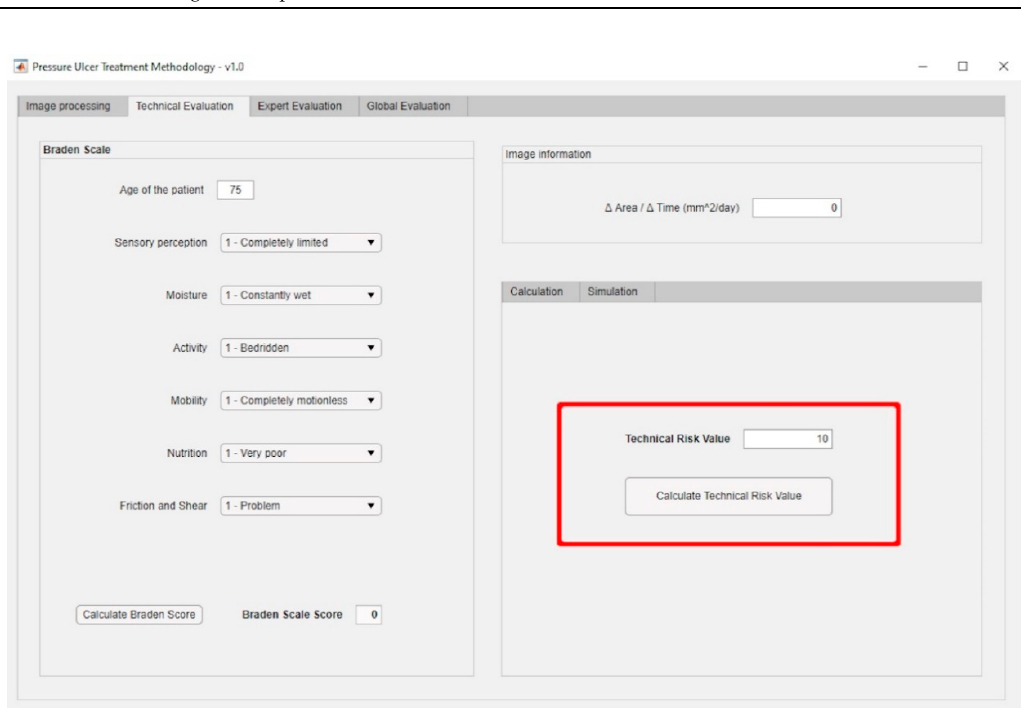
Figure 6. Diagram of the Technical Risk inference system operation.